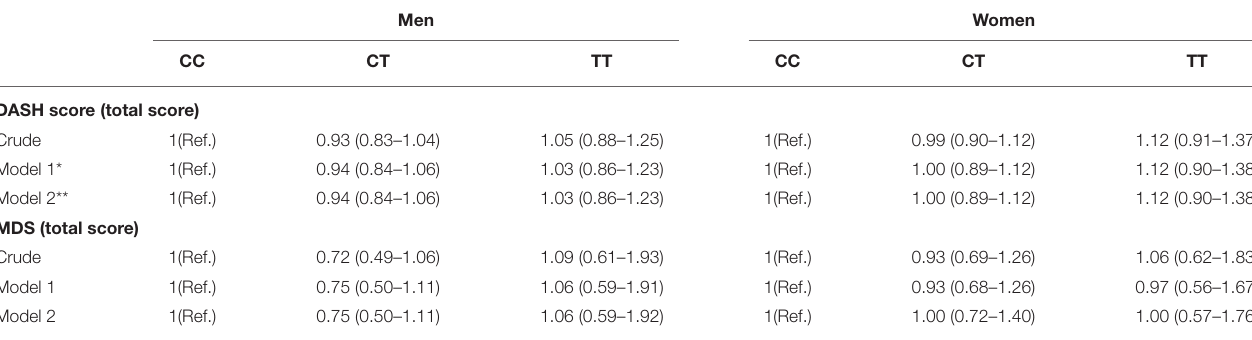
TABLE 5 | Odds ratio (OR) and confidence interval (CI) for the association between dietary quality indices and FADS2 rs174583 genotypes.